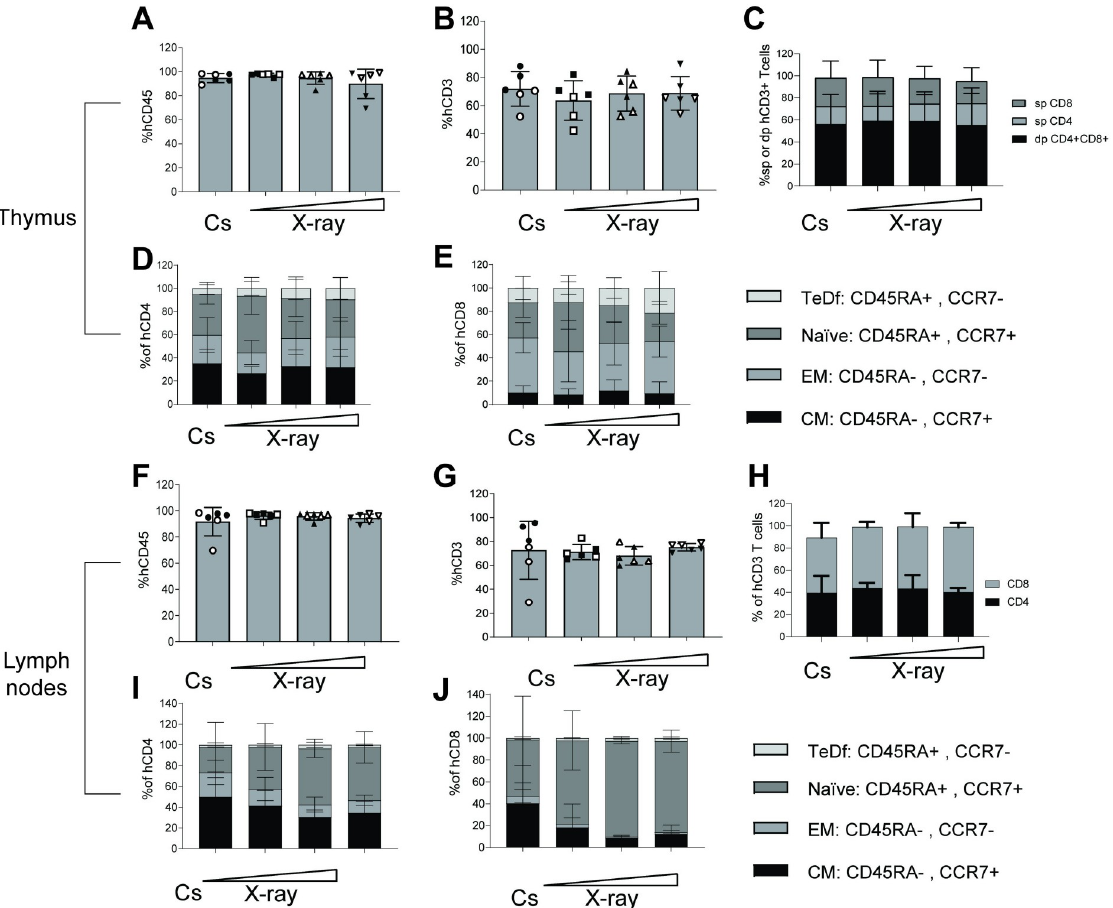
Fig 4. Thymopoiesis and lymph node tissues in NOG mice humanized following either irradiation from a Cs source an X-ray device. (A) Bar graph for each irradiation group showing the percentage of human cells based on expression of hCD45 out of total WBCs identified in a forward/side-scatter flow cytometry gating plot in thymi. (B) Bar graph of the frequencies of human T cells based on expression of surface hCD3 in thymi. (C) Bar graphs of the human CD3 T cells identified into either CD4 single positive (sp), CD8 sp or CD4CD8 double positive (dp) in thymi. (D)+(E) Distribution of either CD4 sp or CD8 sp T cells into four maturation stages, i.e. na ï ve, central memory (CM), effector memory (EM) or terminally differentiated (TeDf) T cells based on surface expression of human CCR7 and CD45RA. (F) Bar graph for each irradiation group showing the percentage of human cells based on expression of hCD45 out of total WBCs identified in a forward/ side-scatter flow cytometry gating plot in lymph nodes (mesenteric, superficial inguinal, brachial, axial and cervical). (G) Bar graph of the frequencies of human T cells based on expression of surface hCD3 in lymph nodes. (H) Compartmentalization of the human CD3 T cells identified into either CD4 sp or CD8 sp in lymph nodes (I+J) Data bars of the frequencies of CD4 and CD8 T cell subsets, respectively based on expression of CD45+ and CCR7-. Each dot represents one mouse (6 mice per group). Data is presented with mean ± S.D. The horizontal triangle ( ◿ ) illustrates increasing doses of X-ray-derived radiation. Stem cell Donor A-derived mice are full circles ( ● ) and Donor B-mice empty circles ( �